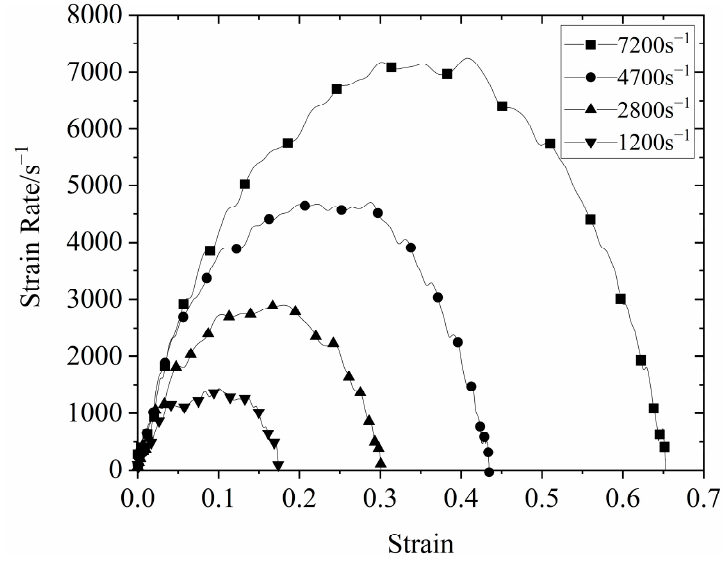
Figure 3. Strain − rate strain curve of silicone rubber at room temperature.